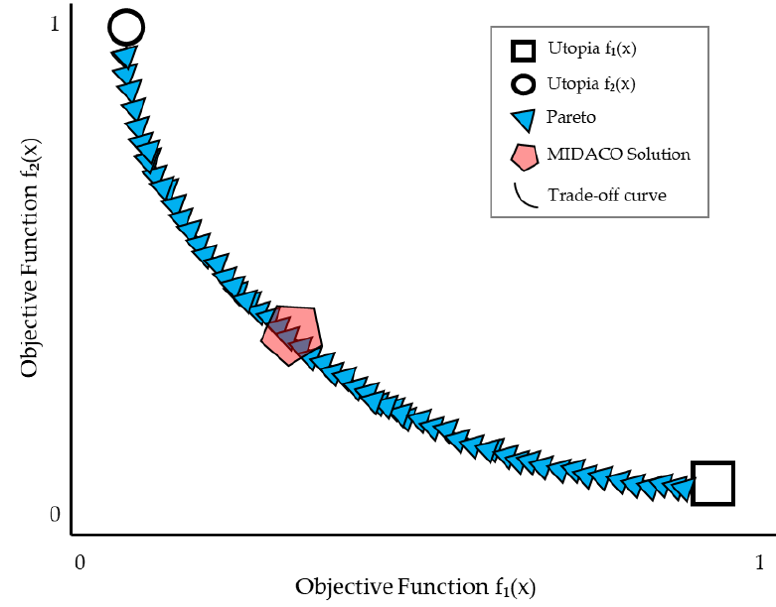
Figure 2. Outline of single optimization in